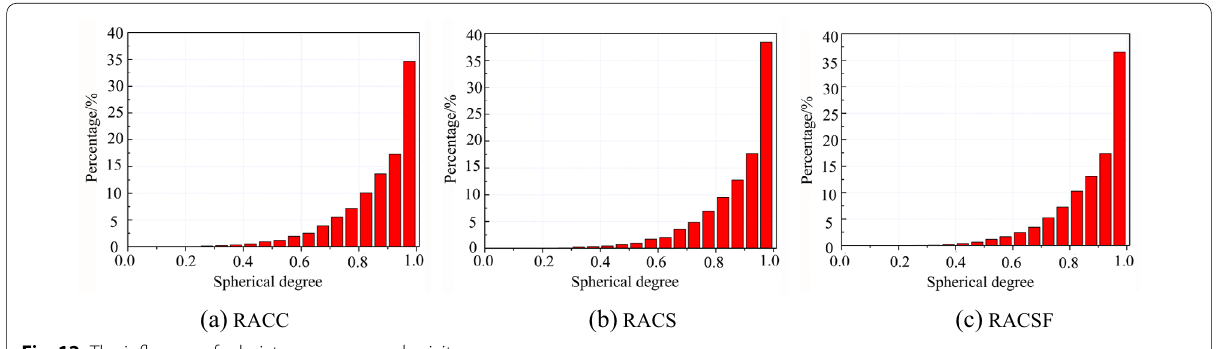
Fig. 12 The influence of admixtures on pore sphericity